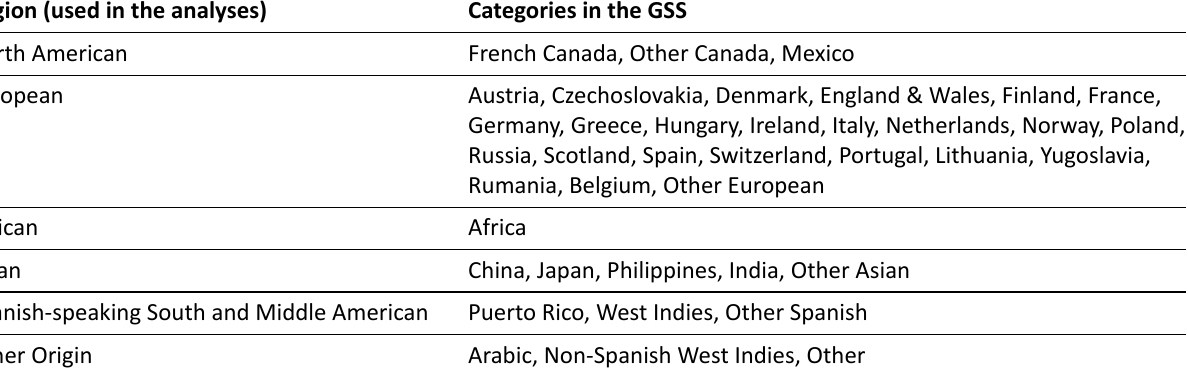
Table A1. Details on the family origin.